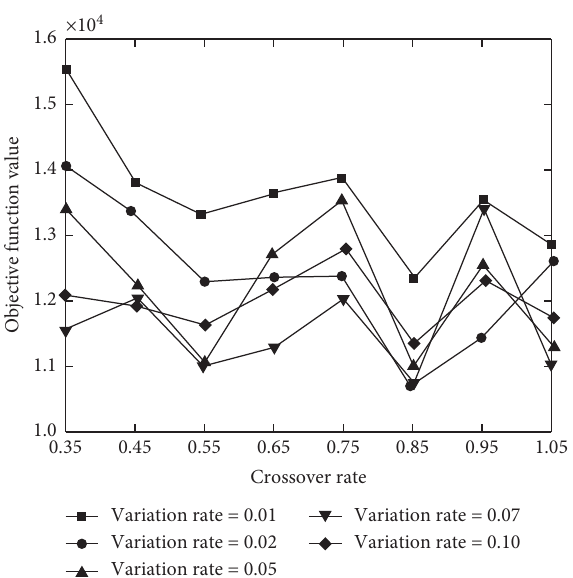
Figure 10: Objective function values under different crossover rates and mutation